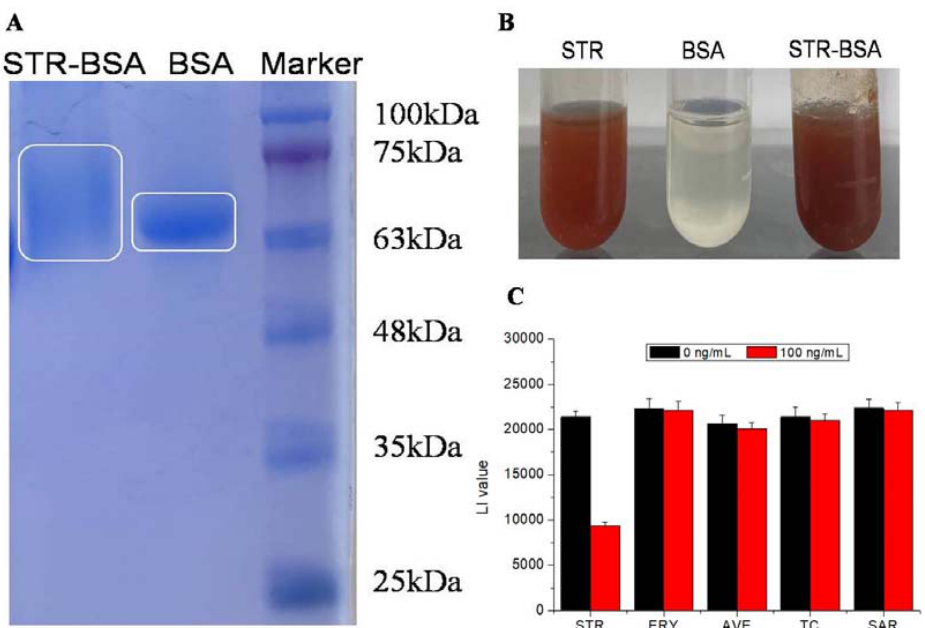
Figure 5. Characterization of the coating conjugate STR–BSA by using ( A ) SDS-PAGE and ( B ) maltol reaction. ( C ) LI values when testing STR and other drugs (SAR =sarafloxacin, TC = tetracycline, AVE = avermectin, ERY = erythromycin, 0 and 100 ng/mL; STR–BSA 1:1000, RpsL12–Rluc 1:1000).